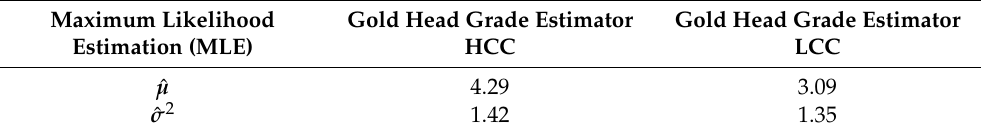
Table 6. Maximum likelihood estimation